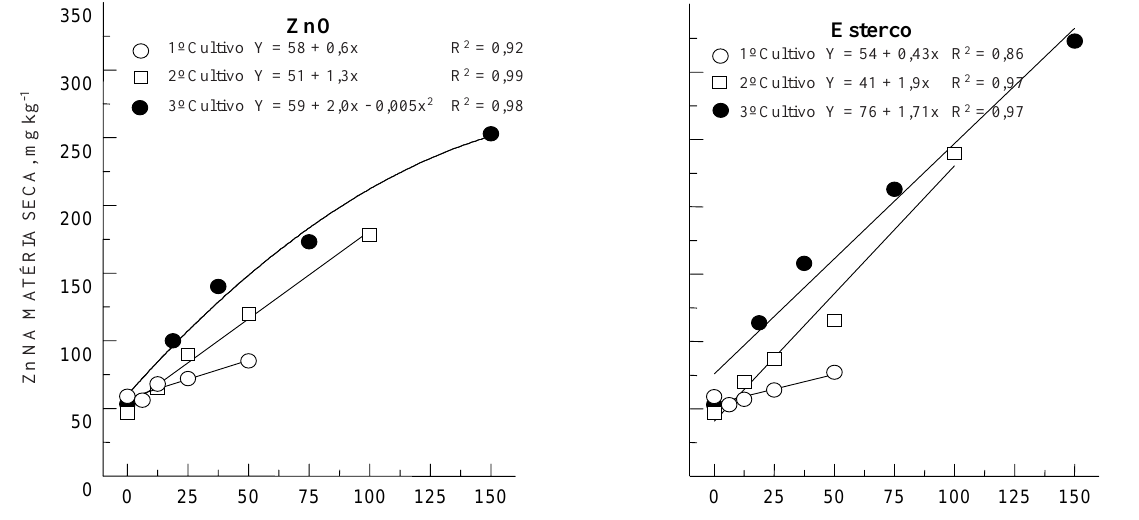
Figura 2. Teores de Zn no tecido vegetal nas amostras dos três cultivos de milho, considerando a aplicação de quantidades crescentes e cumulativas de Zn na forma de esterco de suínos ou de ZnO. Média de três repetições.